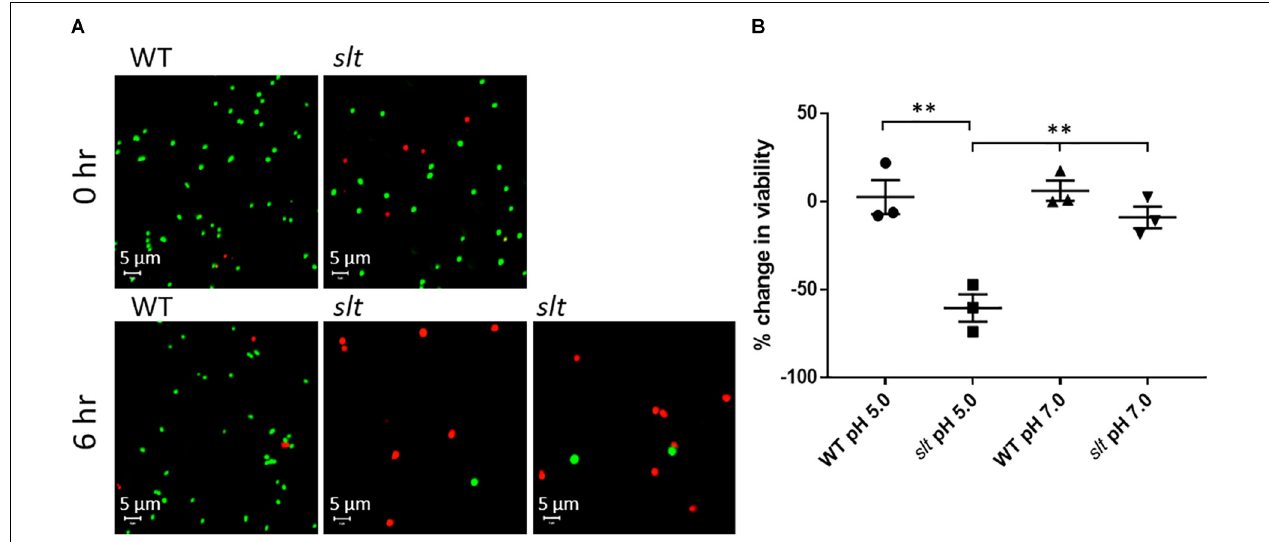
FIGURE 5 | Live/Dead staining analysis of Fn WT and slt . Cells were grown in CDM adjusted to either pH 5.0 or 7.0 and subjected to Live/Dead staining and confocal microscopy at 0 and 6 h time points. (A) Representative confocal images of WT and slt strains grown in CDM pH 5.0. (B) The percentage of viable cells was calculated as number of green-stained cells divided by the total number of cells, and then used to determine the percent change in viability from 0 to 6 h of growth. The mean and standard error were plotted for three independent experiments, wherein at least 100 cells were counted for each sample. Significance was determined by student’s t -test; ∗∗ P < 0.01 for slt pH 5.0 compared to each other sample.